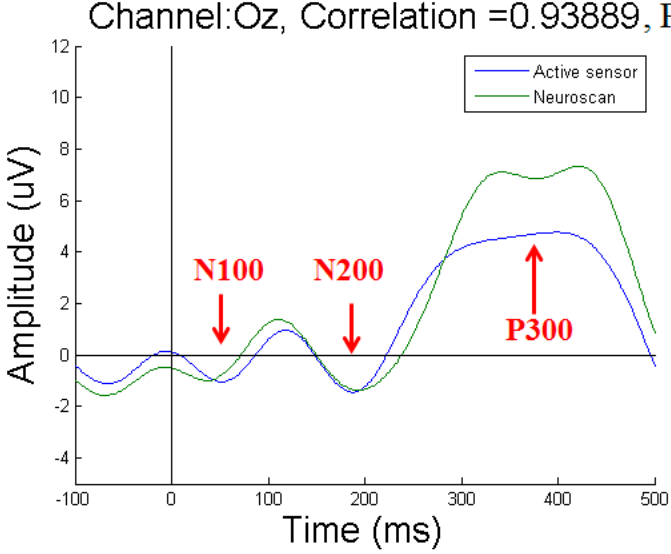
Figure 10. Event-related potential (ERP) results for subject 1 at Oz.